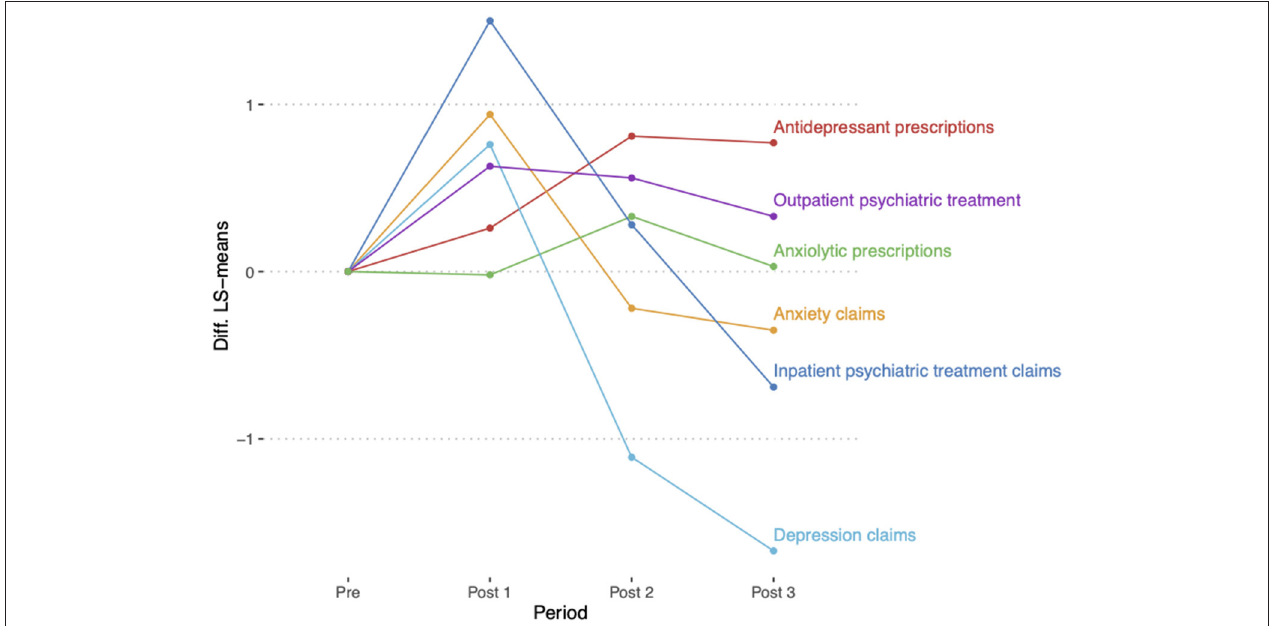
FIGURE 1 | Comparison of mental health utilization between post- and pre-intervention periods. Differences in the least square means (LS-means, predicted population margins in logit scale) were calculated for each outcome for each post-intervention period compared to the pre-intervention